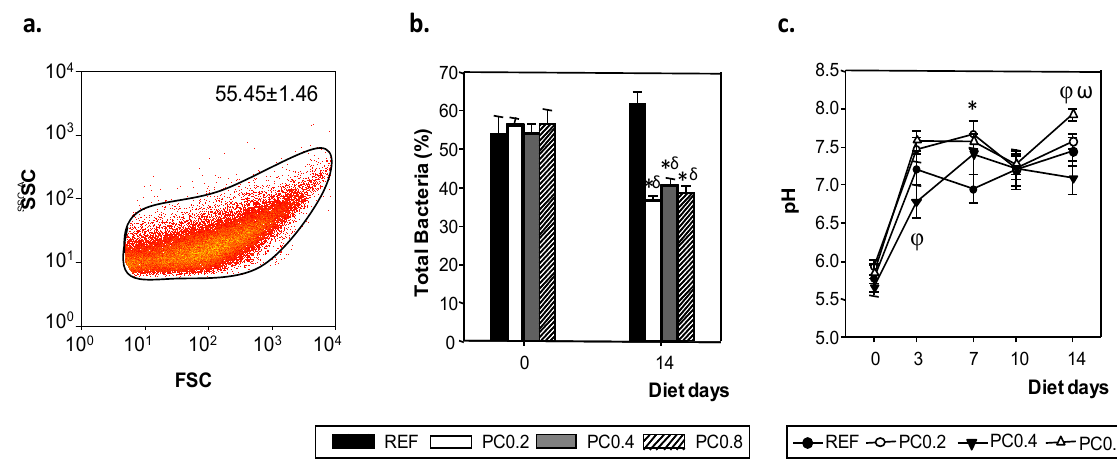
Figure 4. Representative biparametric cytogram showing the initial acquisition gate to select the bacterial population according to its forward- and side-scattered light (FSC/SSC) signal with the mean ± SEM of all groups at the baseline ( a ). Effect of cocoa polyphenol-enriched diets on total bacteria ( b ) and fecal pH ( c ) after two weeks of nutritional intervention. Results are expressed as mean ± SEM ( n = 6). Statistical differences: δ p < 0.05 vs. initial values, * p < 0.0167 vs. REF, φ p < 0.0167 vs. PC0.2 and ω p < 0.0167 vs. PC0.4 in same day of